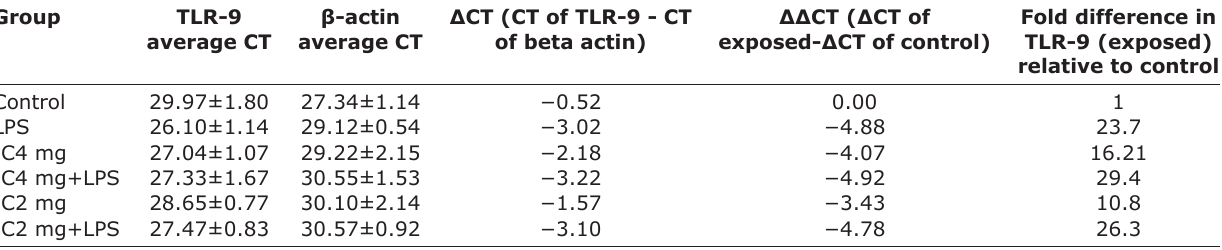
Table-1: Fold change expression of TLR-9 mRNA following oral exposure to indoxacarb (4 and 2 mg/kg) for 90 days with and without LPS. Group